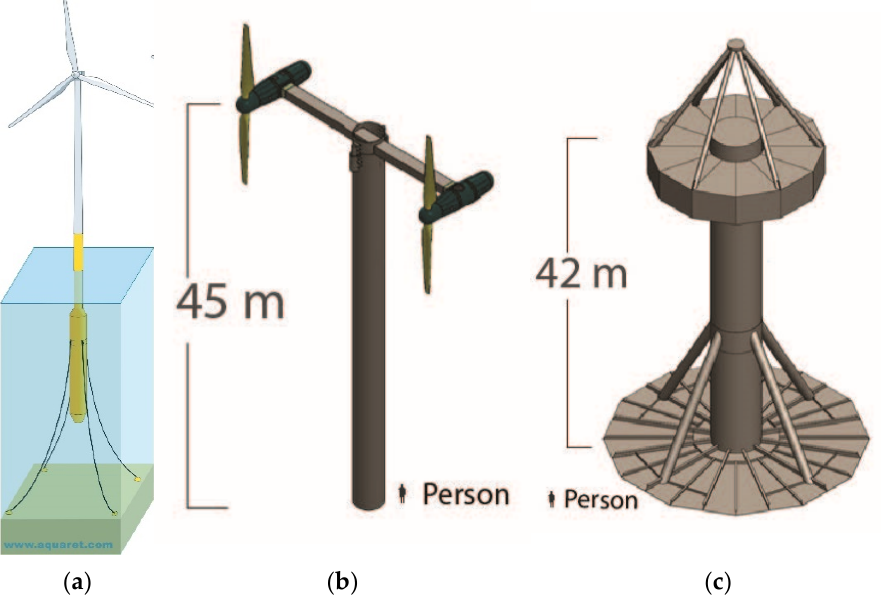
Figure 3. Illustrative representations of the three case studies; ( a ) spar-type floating offshore wind system, adapted from [18] and reproduced with permission from aquaret.com ©Aqua-RET Project (EU Lifelong Learning Programme Agreement No LLP/LdV/TOI/2009/IRL–515), ( b ) RM1 tidal current reference model and ( c ) wave point absorber reference model RM3, reproduced with permission from Sandia National Laboratory [19,20].